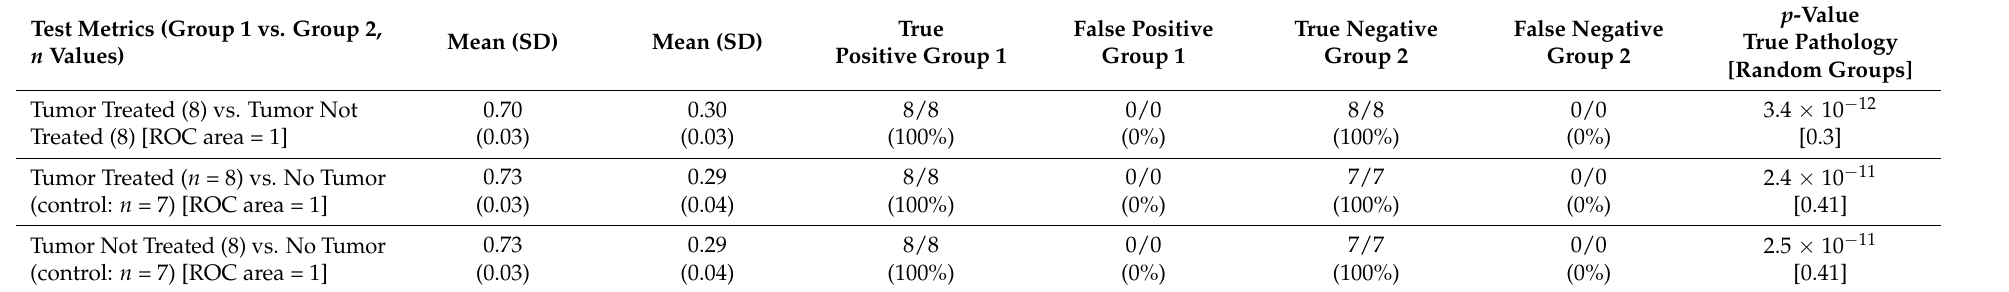
Table 1. LOOCV Statistics and test metrics for rodent brain tumor and control ESI-MS serum mass profiling.